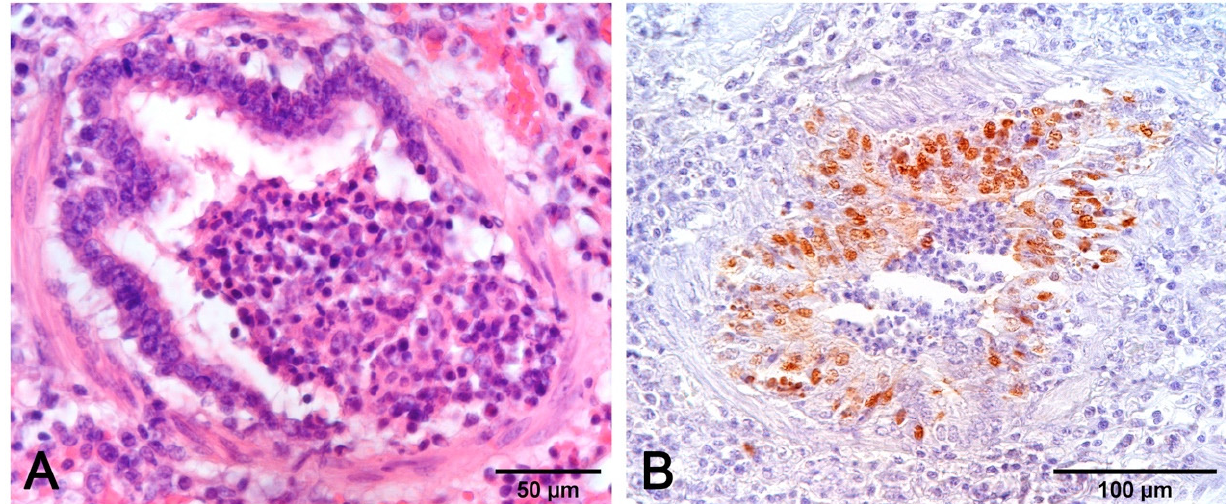
Figure 9. Airways epithelium necrosis ( A ) is a hallmark of SIV infection, but the lesion is shared with other pathogens and the acquisition of etiologic indication is imperative. The opportunity to have positive results by IHC ( B ) is contingent on time, because the lungs can rapidly clear the virus. In this case, sampling on animals with very recent and acute symptoms, in association with other investigations (PCR, serology), provides useful data (( A ): H–E stain; ( B ): IHC with monoclonal anti-SIV antibody clone 1331. Meridian Life Science, Inc.).